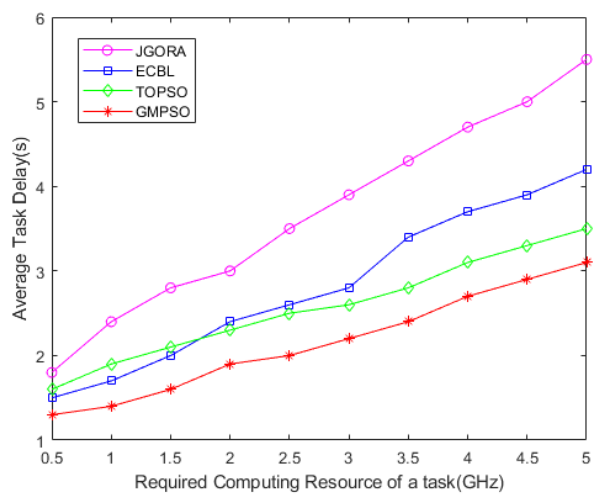
Figure 4. Average task delay against computation load.